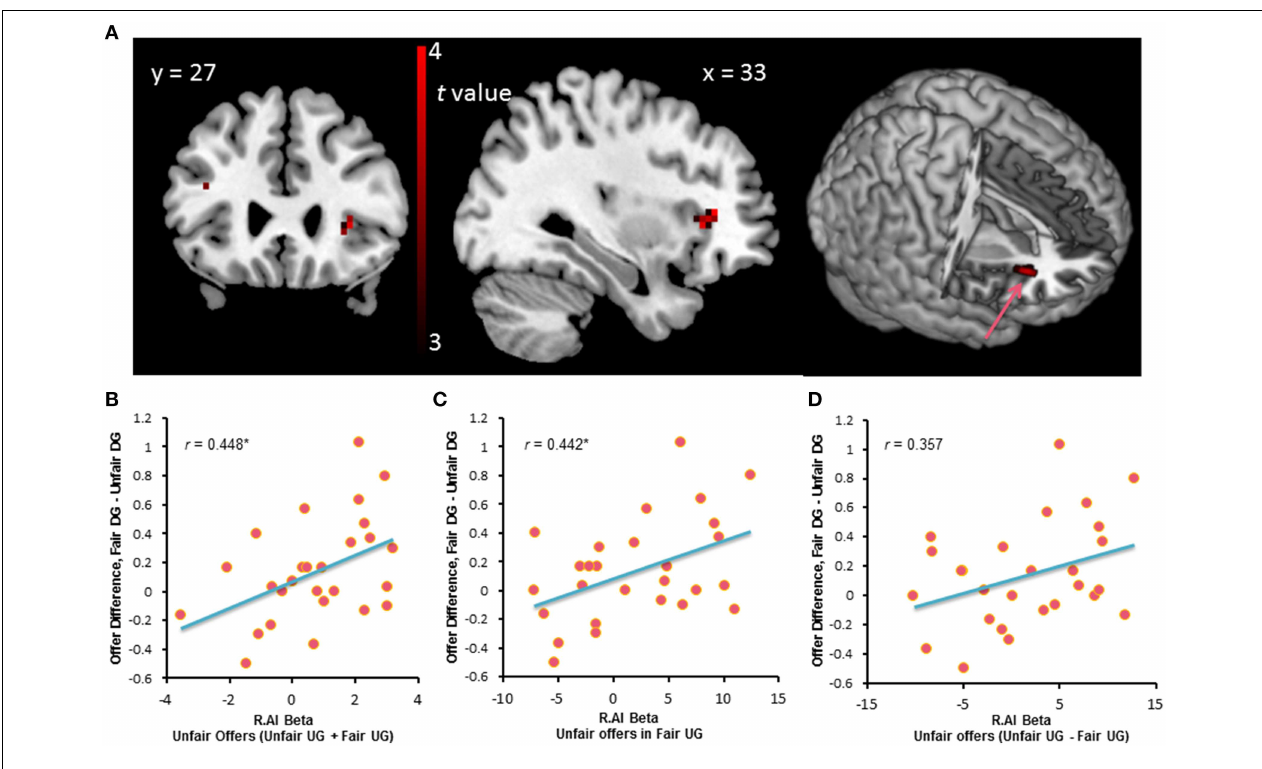
change in DG. ∗ p < 0 . 05 (two-tailed). (D) There was a trend that the behavior change in DG correlated with the differential activation in the right dorsal anterior insula during unfair offers between the fair UG and the unfair UG.